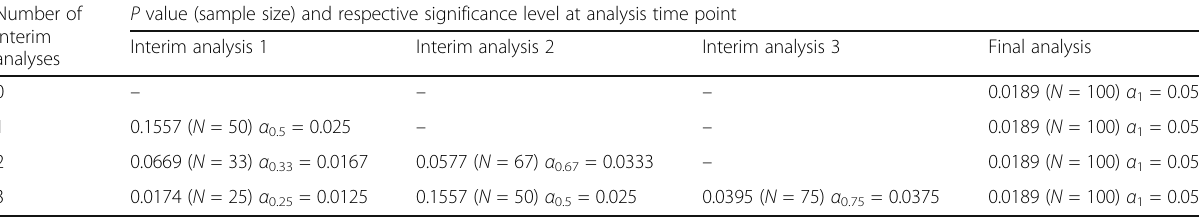
Table 3 Sequential testing on equality of areas under ROC curves [17] Number of interim